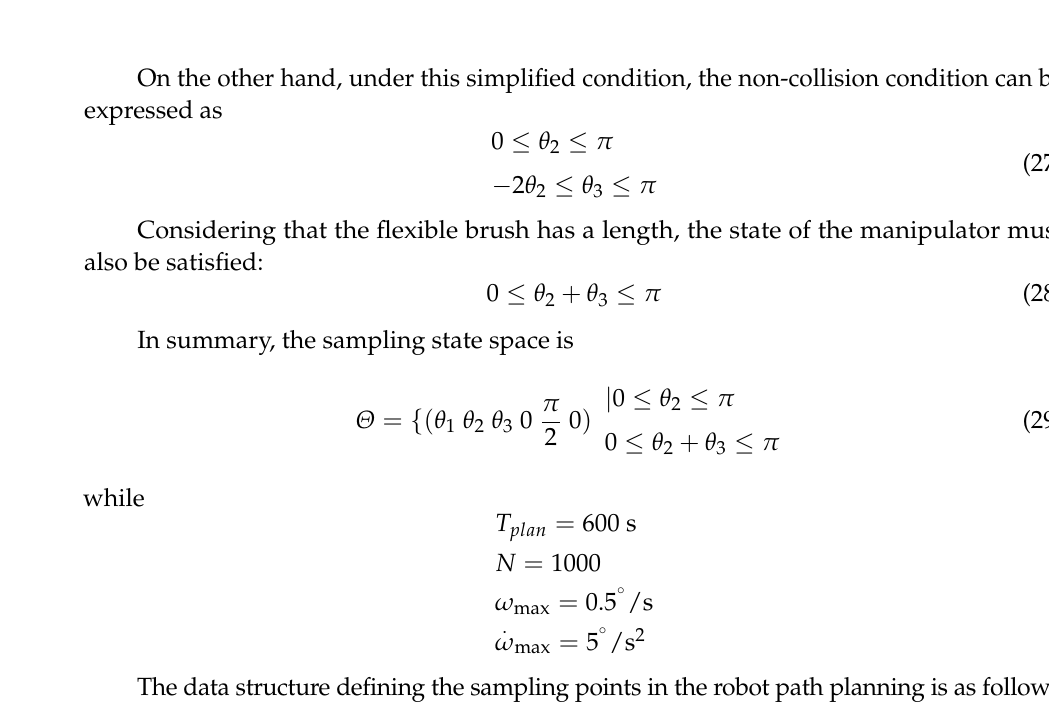
Figure 12. Manipulator trajectory planning results. 5. Conclusions and Future Work With the development of space exploration technology and space commercial activ- ities, the number of spacecrafts in space is sharply increasing, and space resources and the environment are facing enormous challenges. On-orbit service (OOS, which consists of on-orbit refueling, on-orbit repairing, on-orbit upgrading and space debris removal) is an effective means to achieve successful space exploration missions and keep the space environment safe. Whether on-orbit assembly or space debris removal, the proximity to non-cooperative targets is important. However, these non-cooperative targets usually